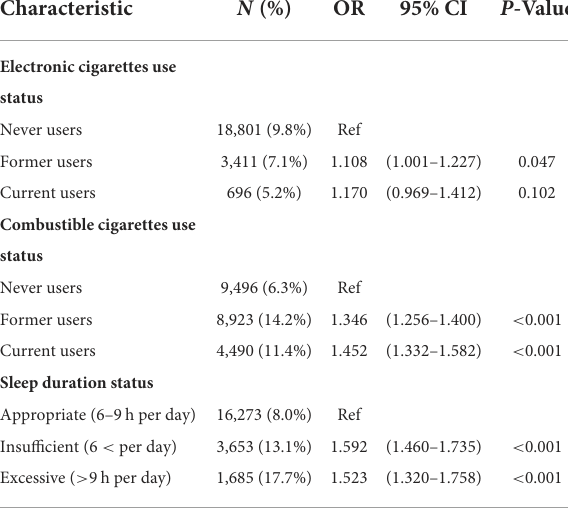
TABLE 2 Association between smoking, sleep duration, and